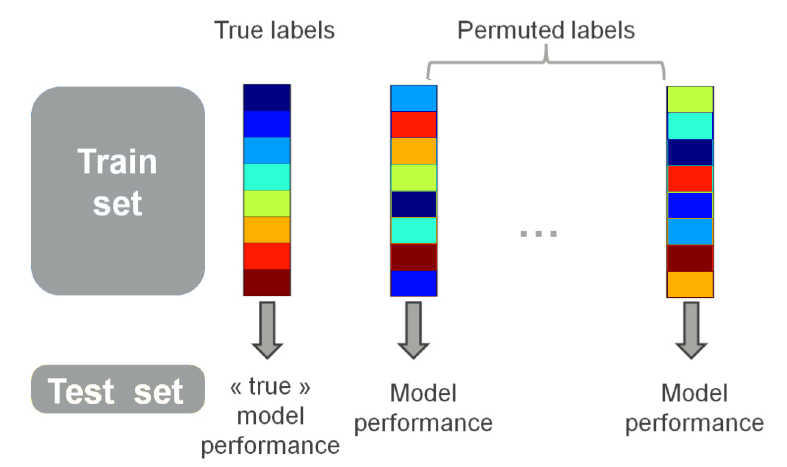
Figure 2. Illustration of the non-parametric permutation